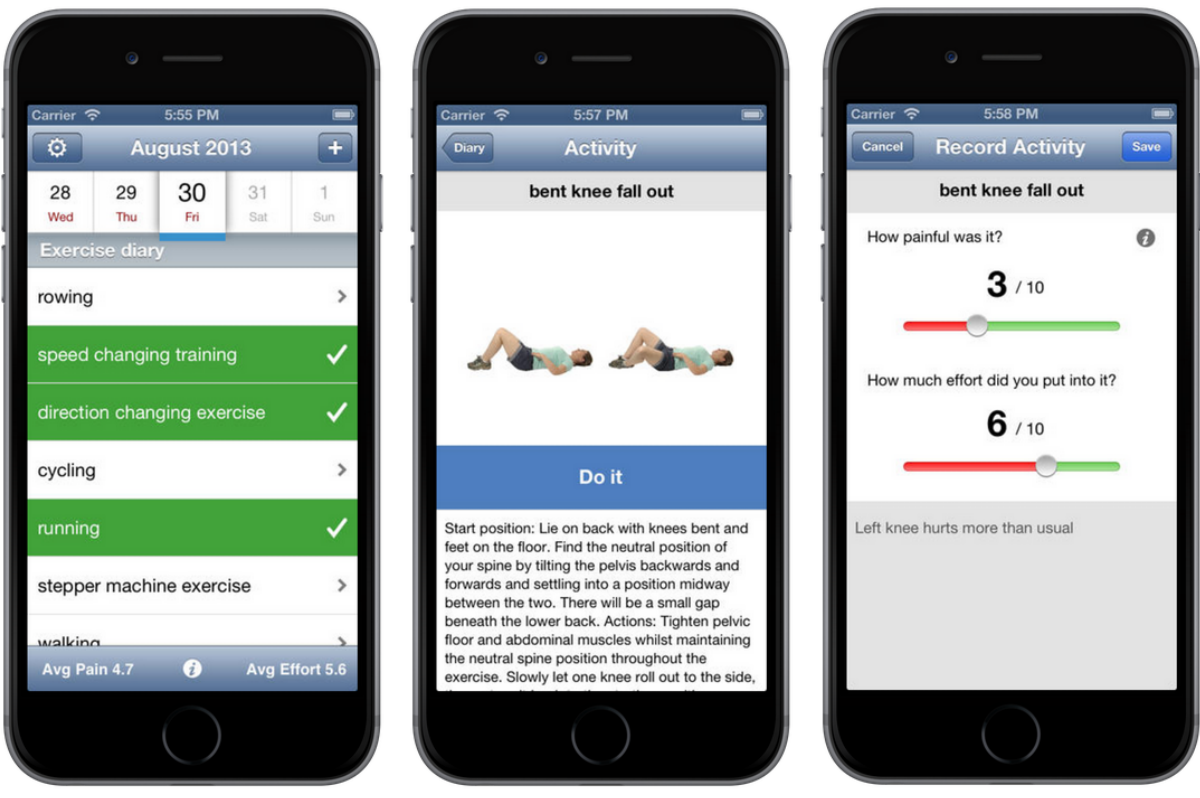
Figure 6. TRAK mobile app allows a patient to keep track of exercises on the